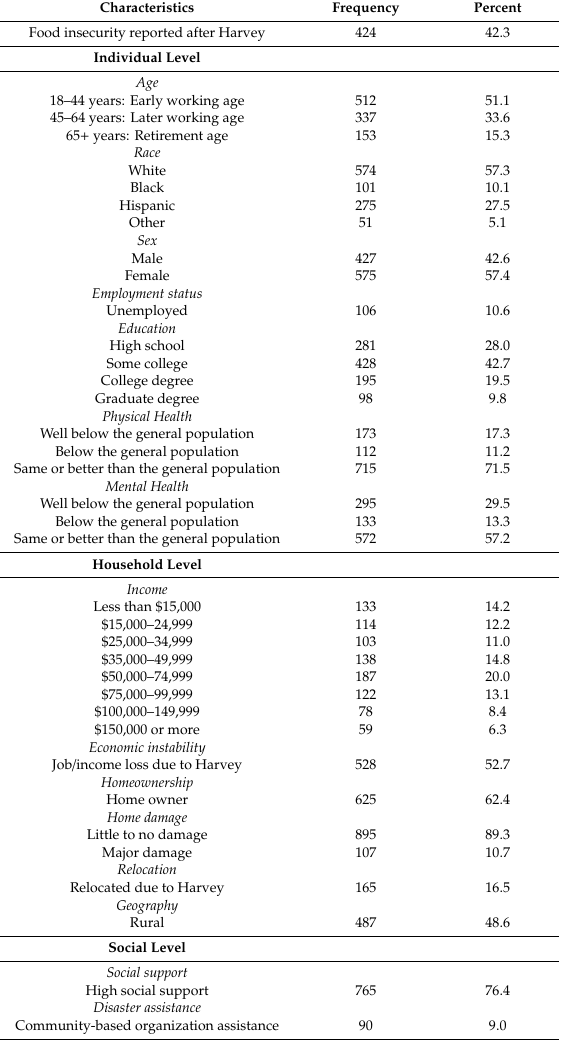
Table 1. Characteristics of the